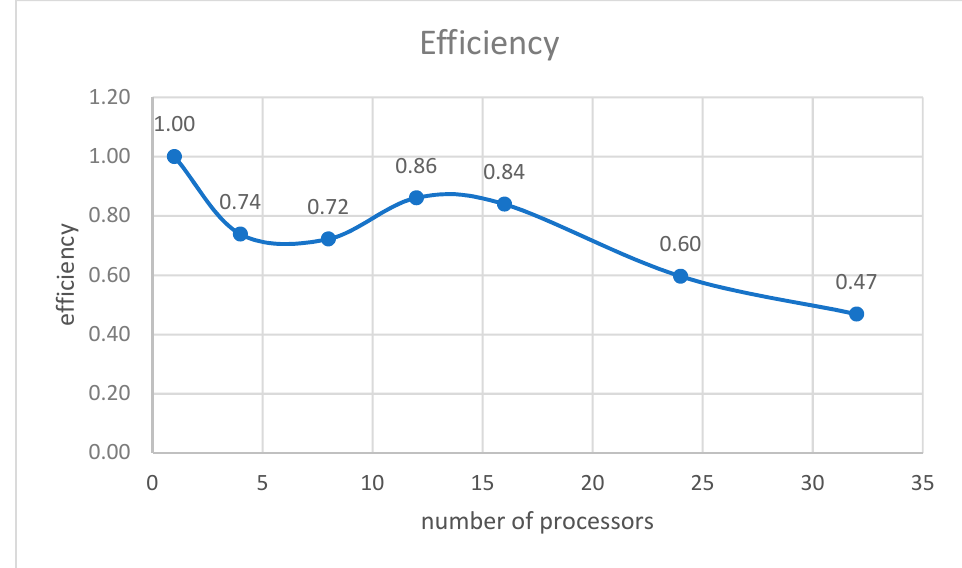
Figure 3. Efficiency diagram. For a problem instance with 100 circles (40 circles with radius 10, 30 with radius 20, 20 with radius 30 and 10 with radius 40) the sequential algorithm results in 𝒓 𝒖𝒑 = 𝟐𝟓𝟕. 𝟑𝟓𝟑𝟏𝟏 . For the same instance, the parallel algorithm with eight processors and 100,000 starting points gives an improved value 𝒓 𝒖𝒑 = 𝟐𝟓𝟕. 𝟏𝟗𝟓𝟏 in 64,649 s (approxi- mately 17 h 58 min). Sequential and parallel solutions are presented in Figures 4 and 5, respectively, while Tables 2 and 3 provide corresponding center coordinates. As can be seen from Figures 4 and 5, the layout for the circles differs significantly. Table 2. Coordinates of the placement of 100 circles for the sequential solution, 𝒓 𝒖𝒑 = 𝟐𝟓𝟕. 𝟑𝟓𝟑𝟏𝟏 .